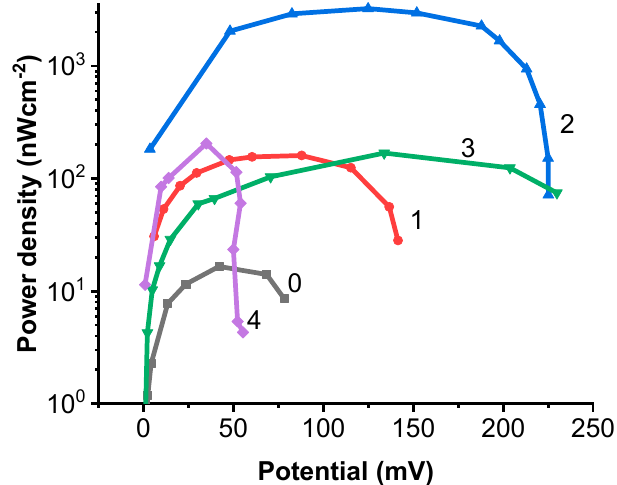
Figure 2. The dependencies of the maximum power density on the potential when the system is: 0— control of the study, 1—EBFC CC ; 2—EBFC CA ; 3—EBFC ChV ; and 4—EBFC Hep . 0—control of the study, 1—EBFC CC ; 2—EBFC CA ; 3—EBFC ChV ; and 4—EBFC Hep